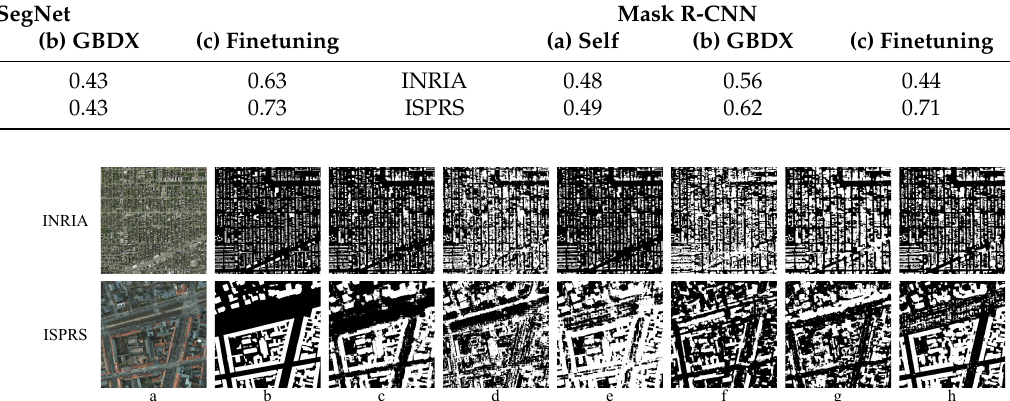
Figure 9. Impact of pretraining and fine-tuning (RQ3): two images from the INRIA (top row) and ISPRS (bottom row) test sets and the predicted masks by our models: ( a ) input image, ( b ) ground truth, ( c ) SegNet trained on INRIA/ISPRS, respectively; ( d ) SegNet trained on GBDX only; ( e ) SegNet pretrained on GBDX and fine-tuned on INRIA/ISPRS; ( f ) Mask R-CNN trained on INRIA/ISPRS, ( g ) Mask R-CNN trained on GBDX only, ( h ) Mask R-CNN pretrained on GBDX and fine-tuned on